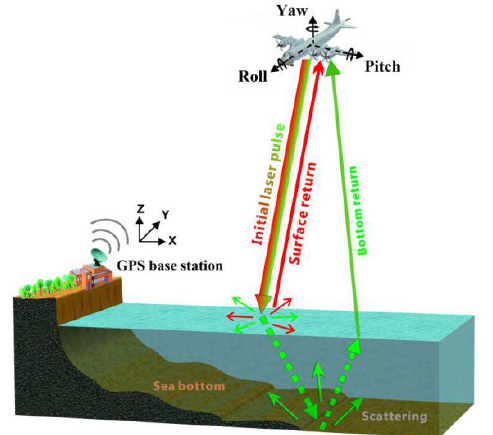
Figure 1. Dual LiDAR working